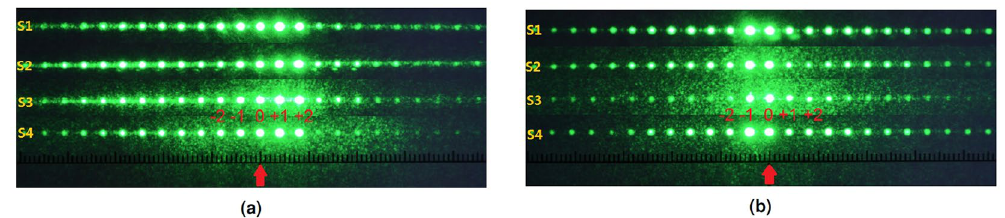
Figure 4. Green laser beam deflection by DFCh-LC-grating beam steering devices with ( a ) the P state and ( b ) the H